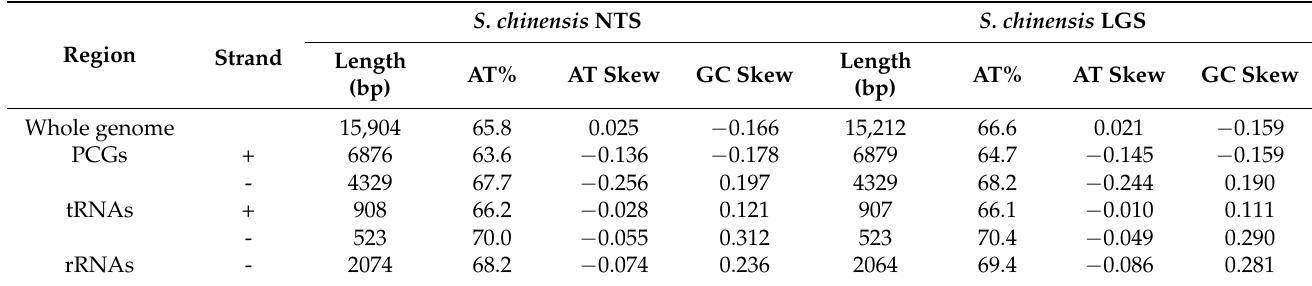
Table S6. In S. chinensis NTS and S. chinensis LGS, the total number of codons